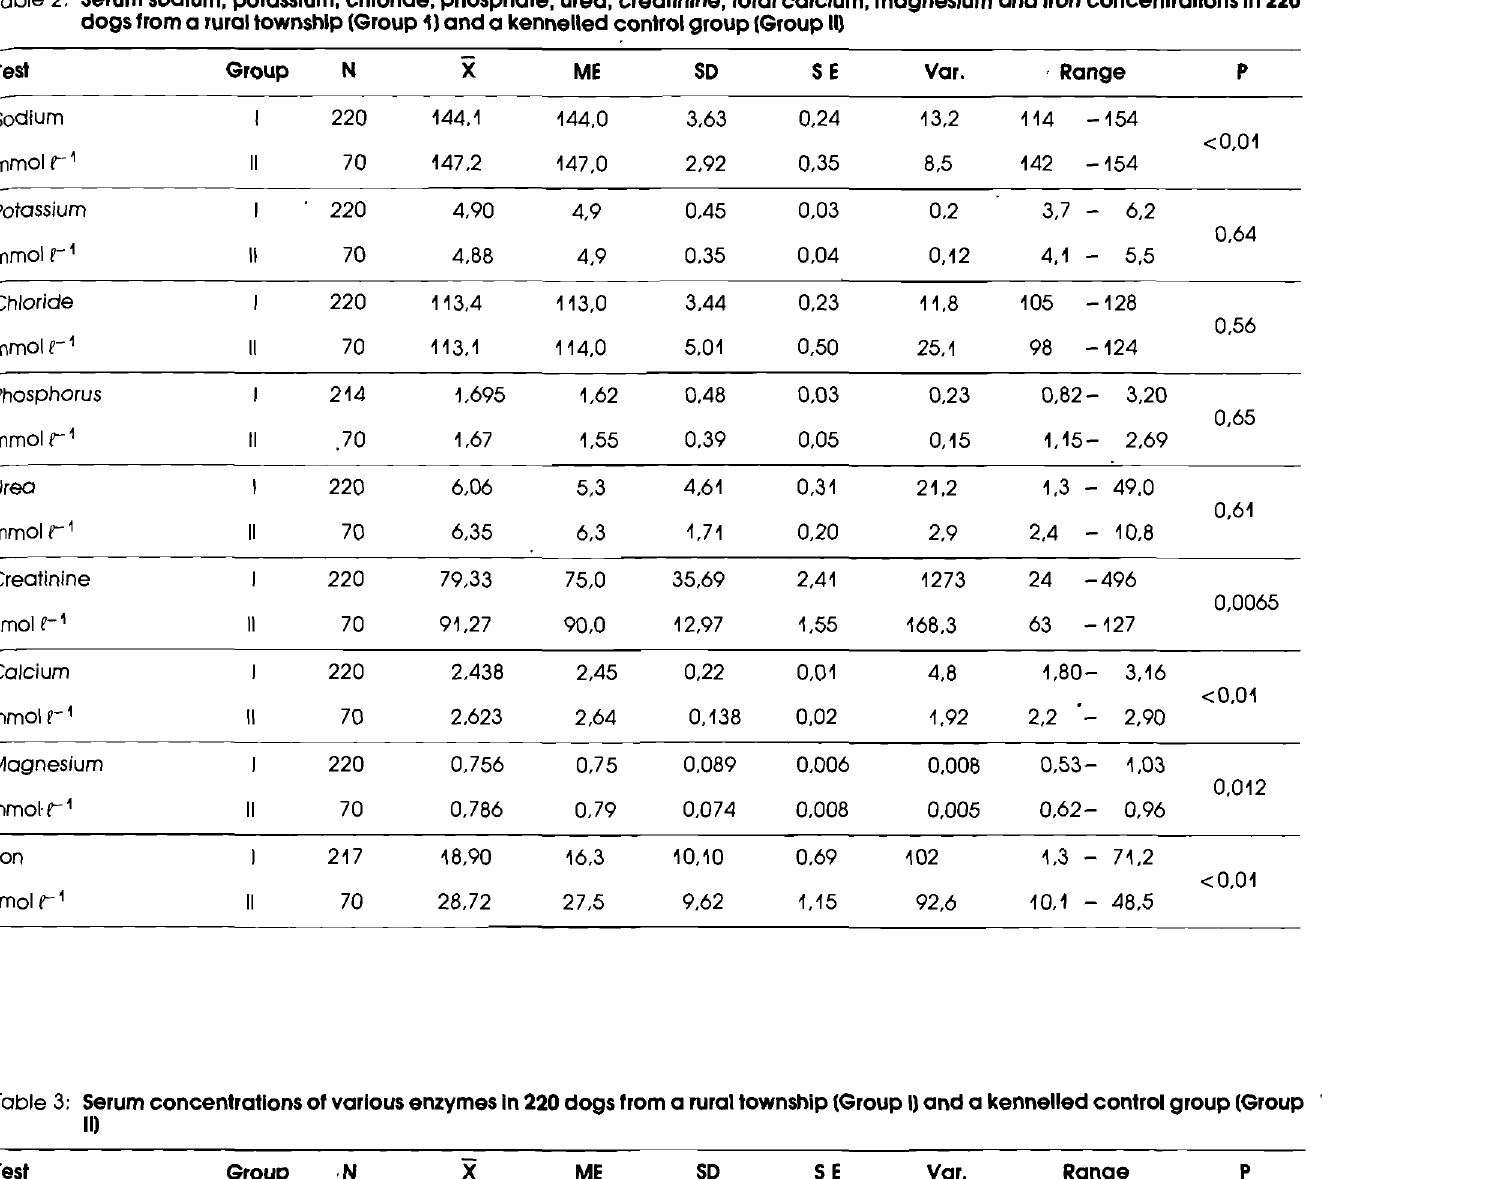
Table 2: Serum sodium, potassium, chloride, Phosphate, urea, creatinine, total calcium, magnesium and Iron concentrations in 220 dogs from a rural township (Group 1) and a kennelled control group (Group II) Test Sodium rnmol r- 1